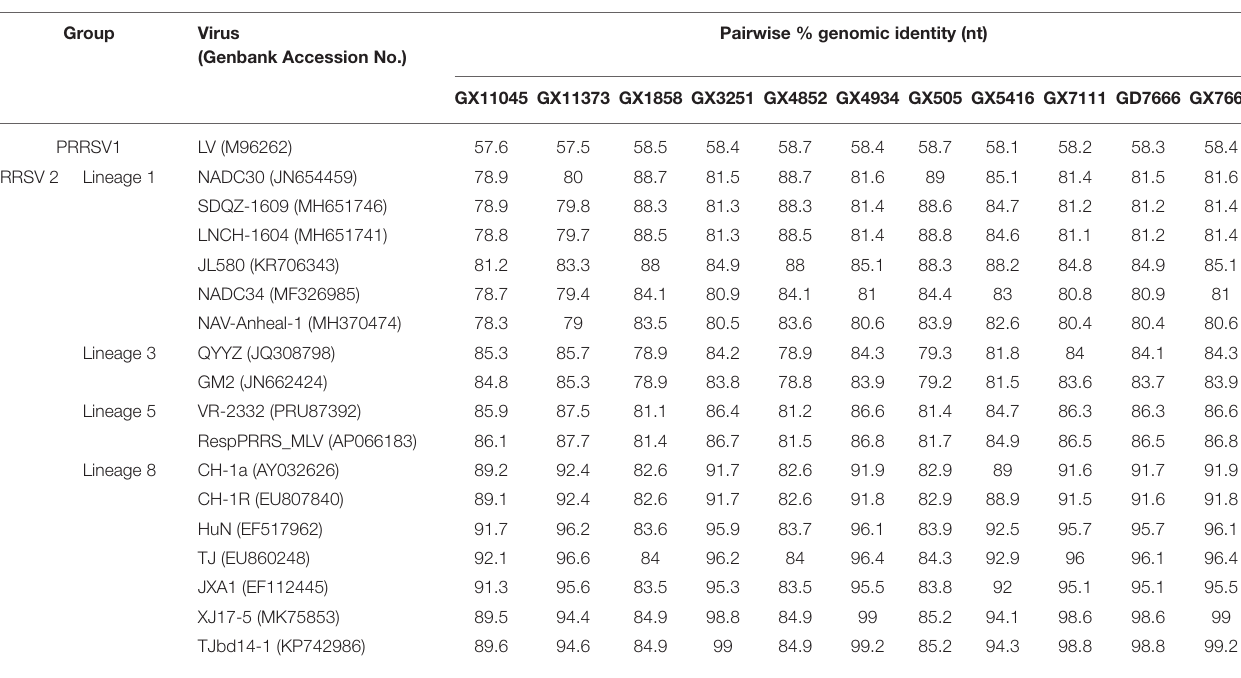
TABLE 5 | Genomic nucleotide identity between the twelve isolates and PRRSV reference strains.